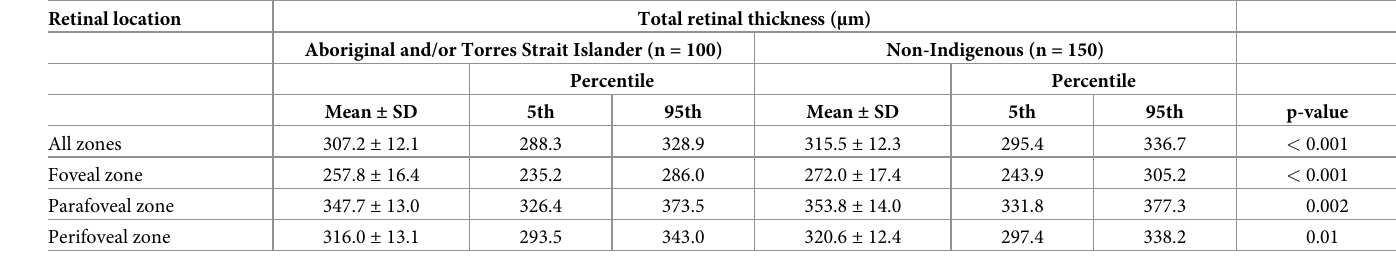
Table 3. Mean total retinal thickness (TRT) across the entire 5 mm zone, and in each retinal zone for Aboriginal and/or Torres Strait Islander children and non- Indigenous children, and results of pairwise